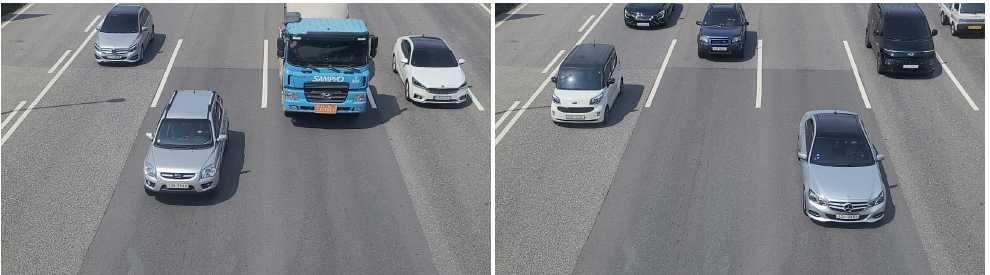
Figure 4. Examples of captured raw images from the installed camera.